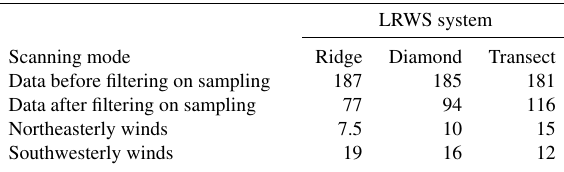
Table 5. Data availability expressed in